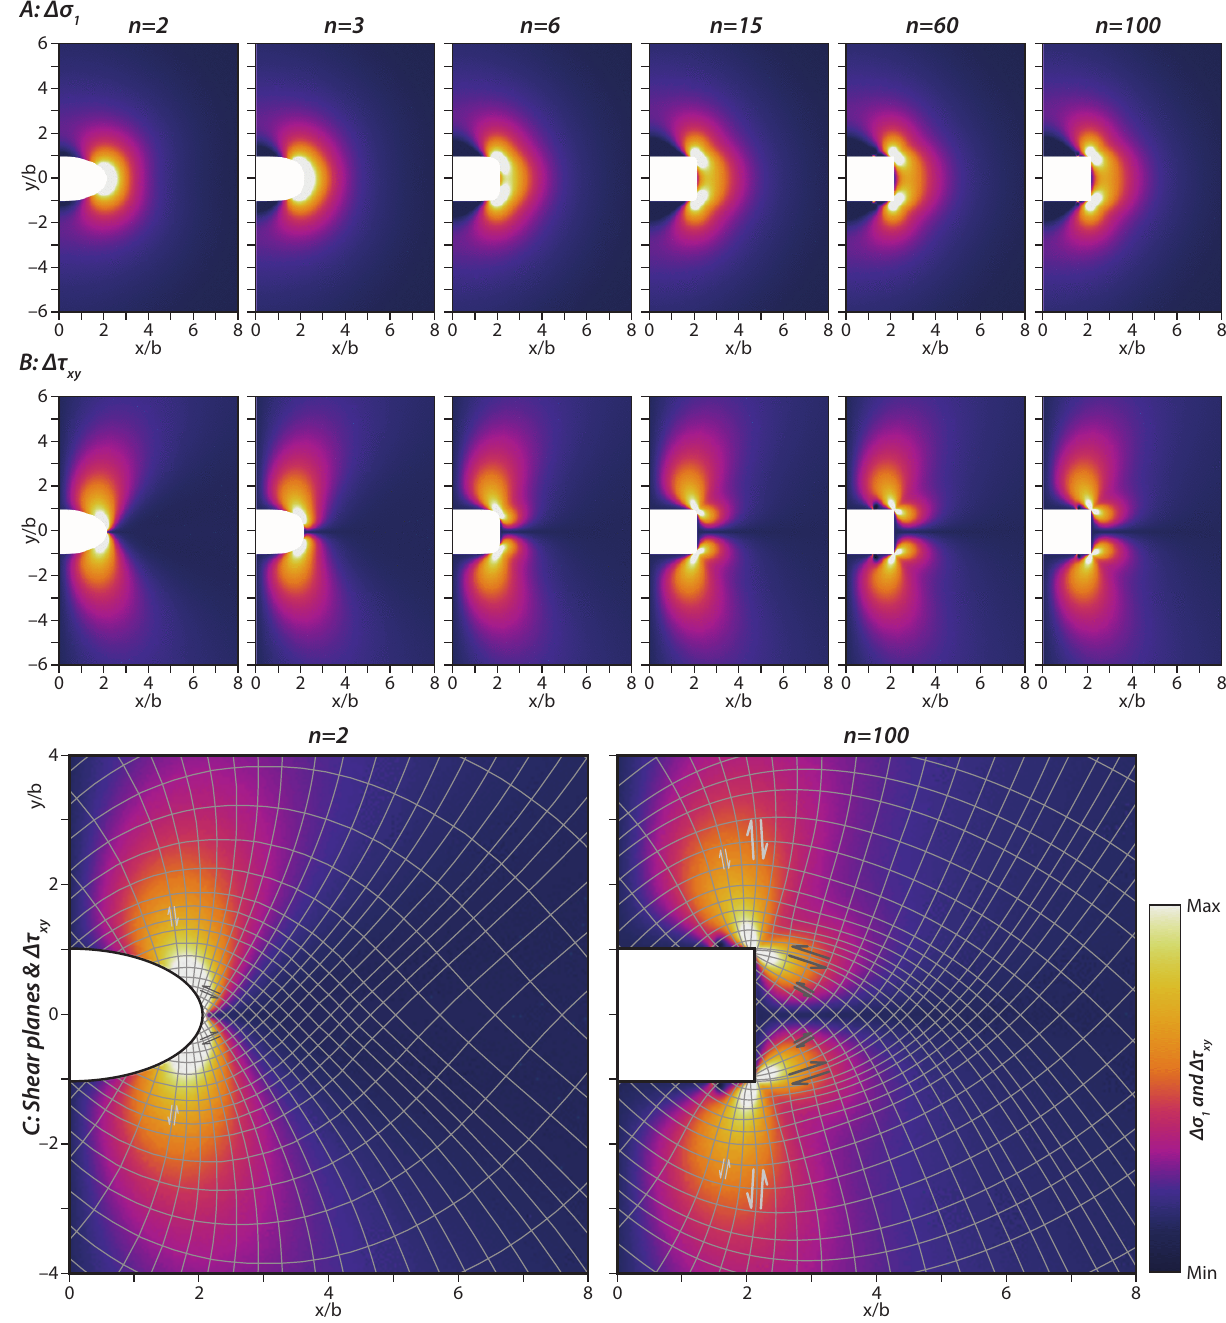
Figure 4: Modelled stress distributions for elliptical to superelliptical tip zones where aspect ratio R “ 2 . [A] Changes in the maximum stress ( ∆ σ ), and [B] changes in shear stress in the xy plane ( ∆ τ ). Absolute values of 1 xy stress are provided in Figure 5. The colour scale data range is uniform for all plots of ∆ σ shown in [A], and uniform 1 for all plots of ∆ τ shown in [B]. Note that maximum ∆ σ , i.e. σ , is along the sill centre axis for n “ 2 , and splits 1 max xy to create two zones of maxima that are increasingly off-axis with increasing values for n . ∆ τ shows a similar xy splitting with increasing n ; stress maxima ( σ and τ ) in the modelled host rock correspond to the position of max max maximum curvature κ . [C] Potential shear (slip) planes [c.f. Pollard 1973] plot onto ∆ τ for n “ 2 and n “ 100 . max xy Light-grey shear-couple arrows show potential slip sense for growth by vertical inflation of the sill, whereas dark- grey arrows show slip sense for horizontal growth by viscous indentation, in both cases accommodated by faulting in the host